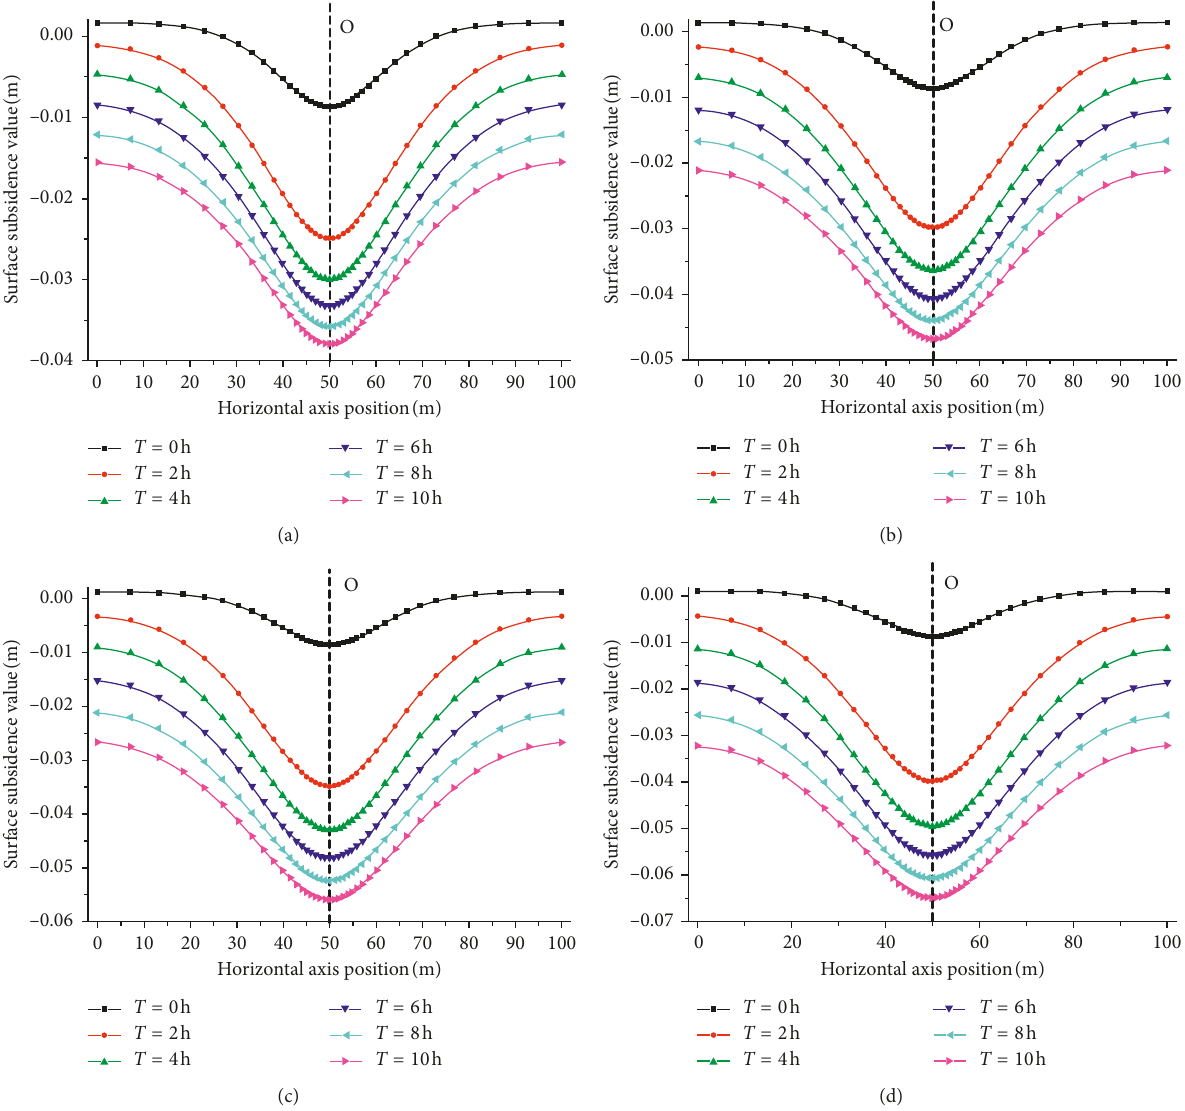
Figure 15: Surface subsidence diagram corresponding to water head difference h at the top of the silty sand layer. (a) Surface subsidence at water head difference h � 4.5m. (b) Surface subsidence at water head difference h � 7.5 m. (c) Surface subsidence at water head difference h � 10.5m. (d) Surface subsidence at water head difference h � 13.5